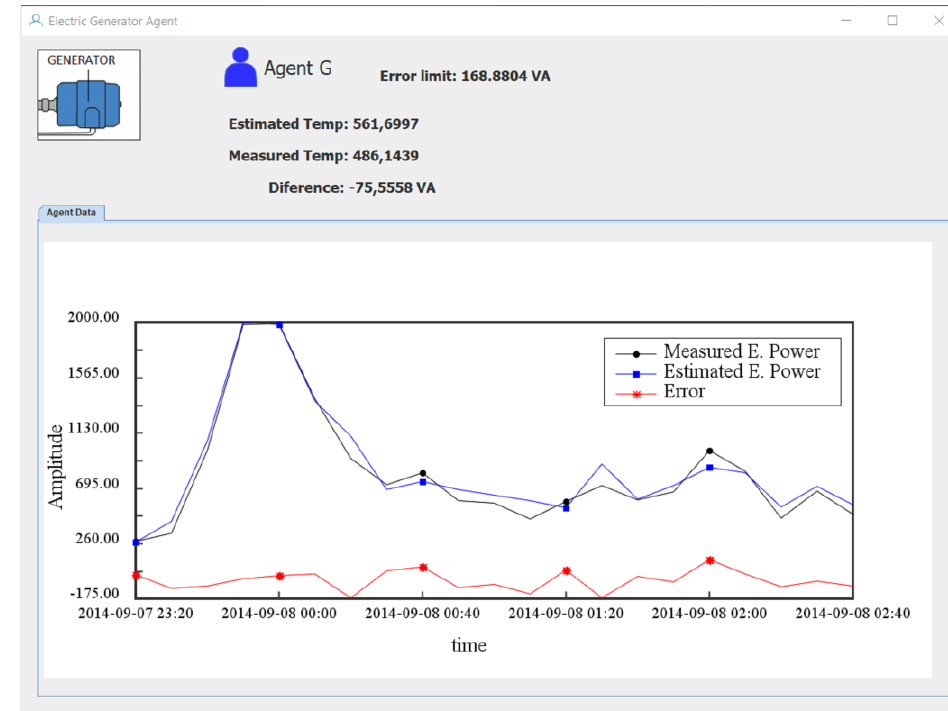
Figure 9. Monitoring graphical interface of Agent